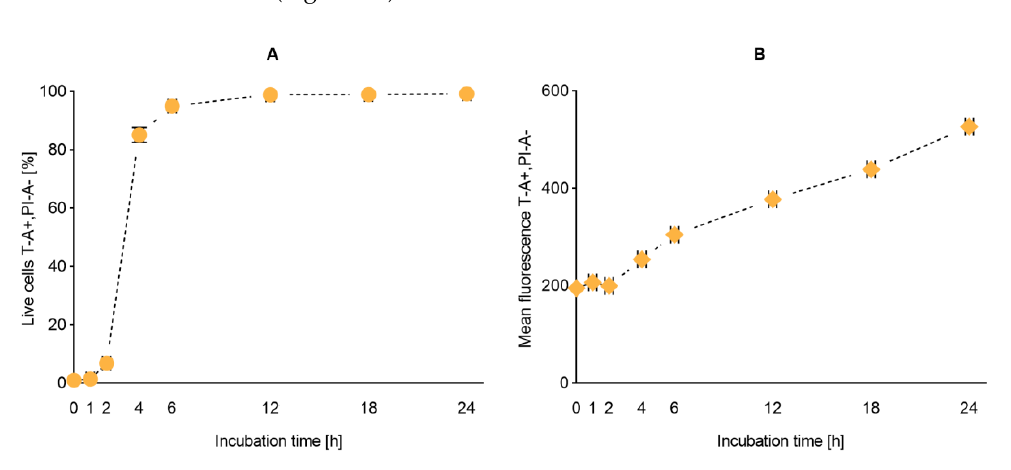
Figure 7. Uptake of T1 liposomes by RAW 264.7 macrophages presented by flow imaging. Four 252 representative pictures are selected for the incubation time of 4 (panel B ), 6 ( C ), 12 ( D ), 18 ( E ) and 24 253